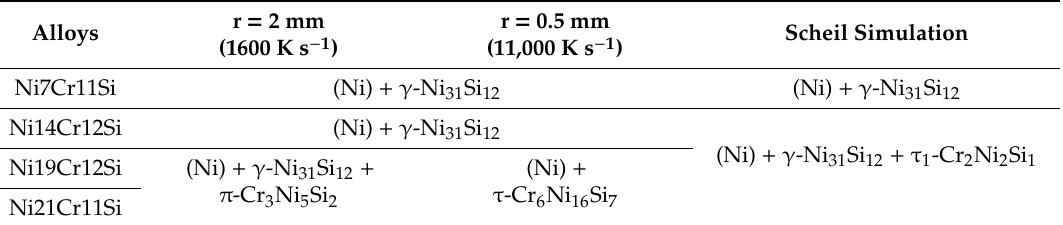
Table 2. Phases observed in the alloys after solidification at di ff erent cooling rates and phases predicted according to Scheil